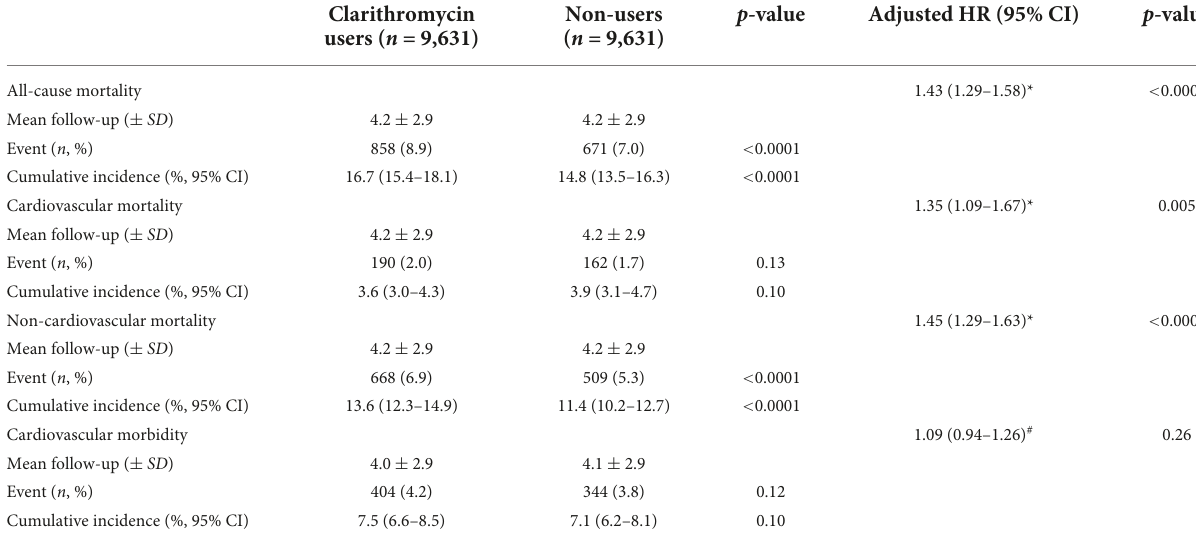
TABLE 2 Outcomes by the use of clarithromycin.